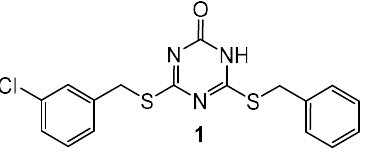
Figure 1. Structure of topoisomerase II inhibitor.